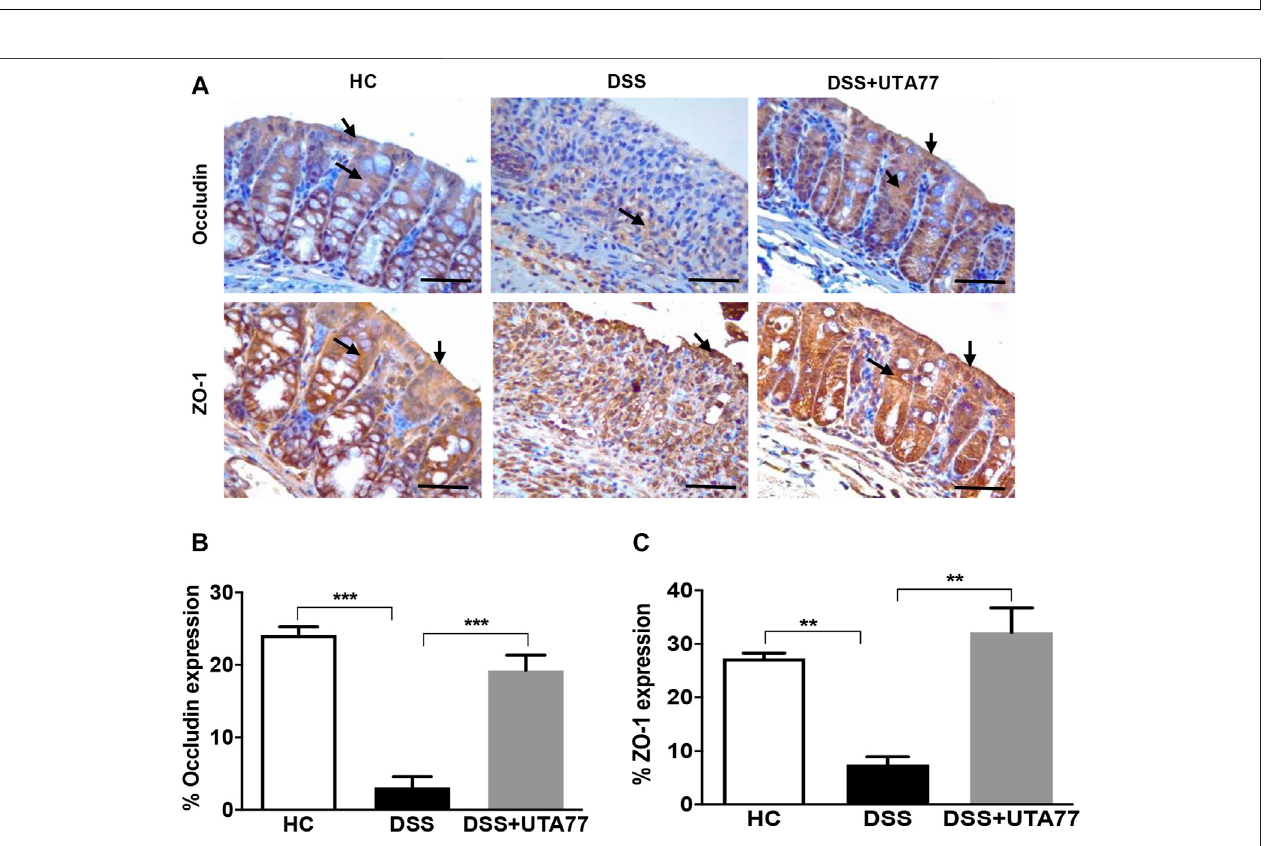
FIGURE5| Effect ofUTA77ontightjunction(TJ) protein expression in DSS-induced experimental colitis. (A) Immunohistochemical analysisofoccludinand ZO-1, (B) averageoccludinexpressionindistalcolon,and (C) averageZO-1expressionindistalcolon.Dataexpressedasmean ± SEM( n (cid:1) 3/group)andstatisticalsigni fi cance evaluated by one-way ANOVA followed by Tukey ’ s posttest where **p < 0.01 and *** p < 0.001. Images at × 40 magni fi cation. Arrow indicates localisation of staining.